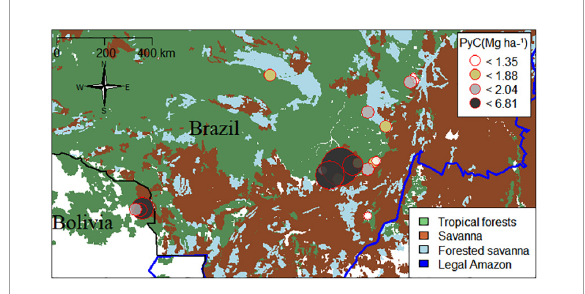
FIGURE2 Spatial variation of pyrogenic carbon (PyC) to 0–30 cm depth along the Amazon-Cerrado transition. Circle colors represent the amount of PyC per hectare; the blue line represents the limit of the Legal Amazon. The plot locations on the map were shifted slightly to avoid overlap with nearby